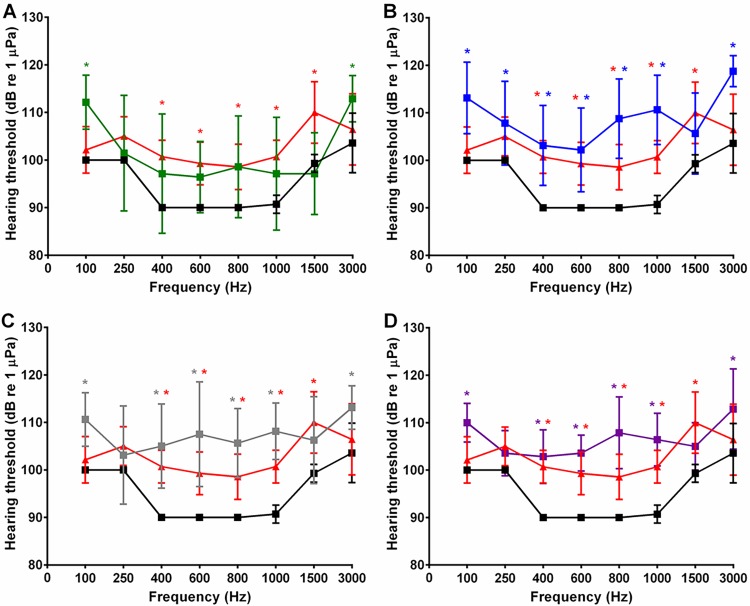
Mean (± SE) AEP hearing thresholds of zebrafish 48 h following injection with either a monofunctional platinum(II) complex, cisplatin, or a vehicle.A.-D. Cisplatin (red) treatment produces threshold shifts between 400 and 1500 Hz; vehicle (black) treatment. A. Pyriplatin (green) treatment only produces a significant threshold shift at 100 Hz. B. Phenanthriplatin (blue), (C) [Pt(dien)Cl]+ (grey), and (D) [Pt(Et2dien)Cl]+ (purple) treatment produces threshold shifts at all but two frequencies (250 and 1500 Hz). N = 8–15; * p ≤ 0.05.